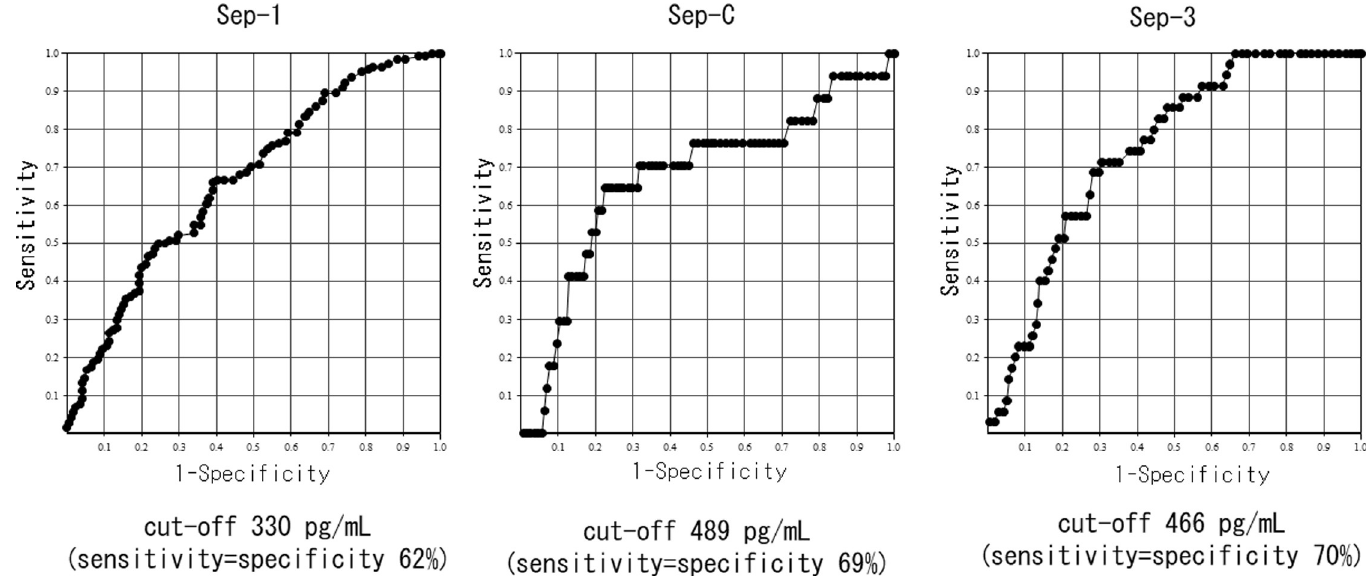
Fig 8. Receiver operator characteristic curve of Pre for each sepsis diagnosis[patients with eGFR � 60 (N = 315)]. AUC: area under the curve. AUCs were as follows: Sep-1: AUC = 0.67 ± 0.03; Sep-C: AUC = 0.68 ± 0.07; Sep-3: AUC = 0.75 ± 0.04.